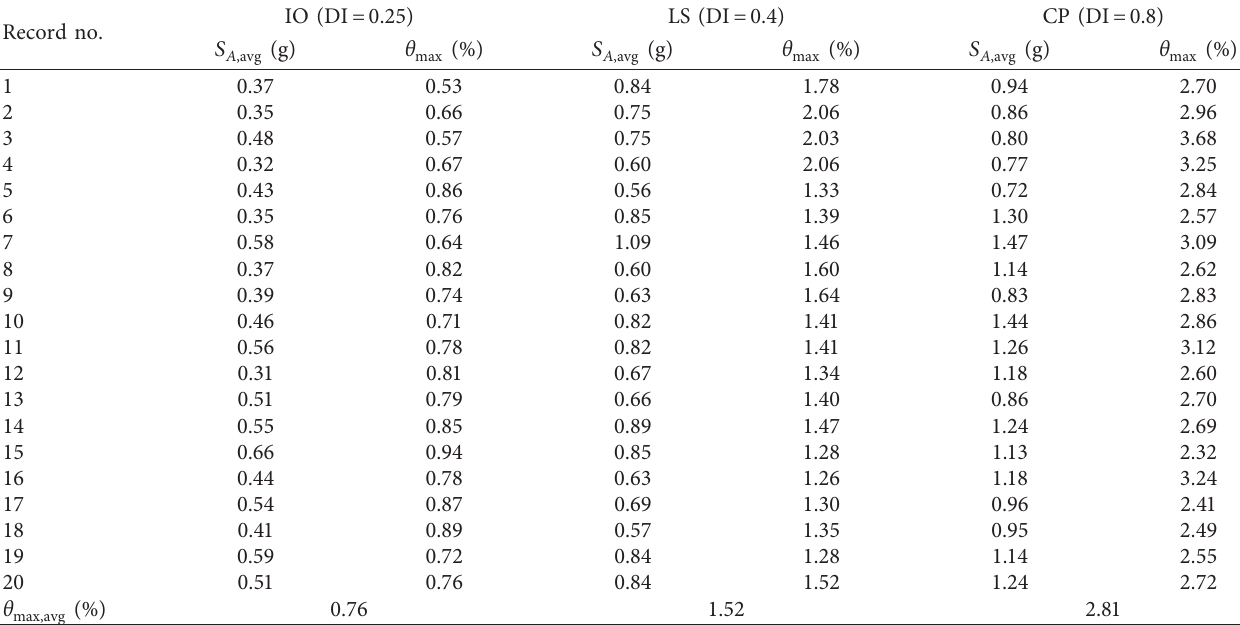
� 0.25, 0.4, and 0.8 in the symmetric model.